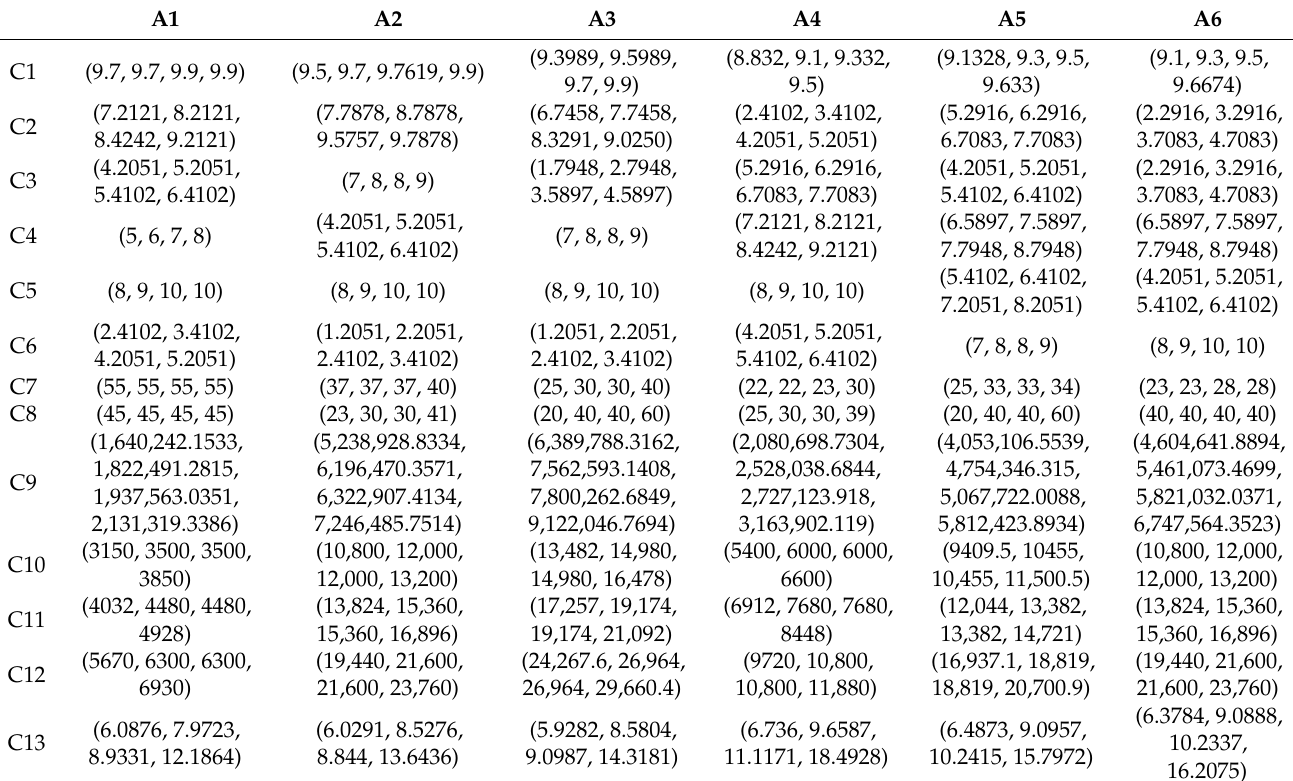
Table 8. Aggregated assessments of alternatives—transposed fuzzy decision